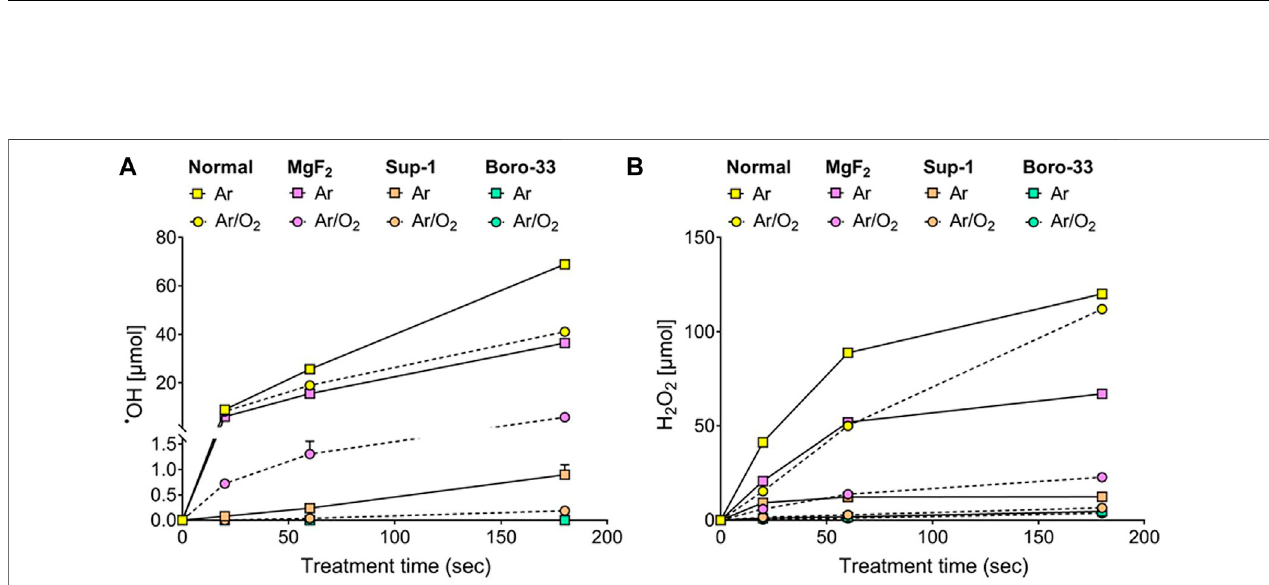
FIGURE5| Formationofhydroxylradicals (A) ,andhydrogenperoxide (B) afterplasmatreatmentsusing3slmAr ± O 2 and5slmshieldinggas(N 2 ).Solutionswere treatedineither24wellplatesorradiationchamber (see Figure1 )withdifferentvolumes duetotechnicalconstraints(seetext).Quanti fi cationperformed via colorimetric (cid:129) assays [ OH according to [72]]; experiment performed in triplicates. Error bars (range) are in some cases smaller than data points and not visible.